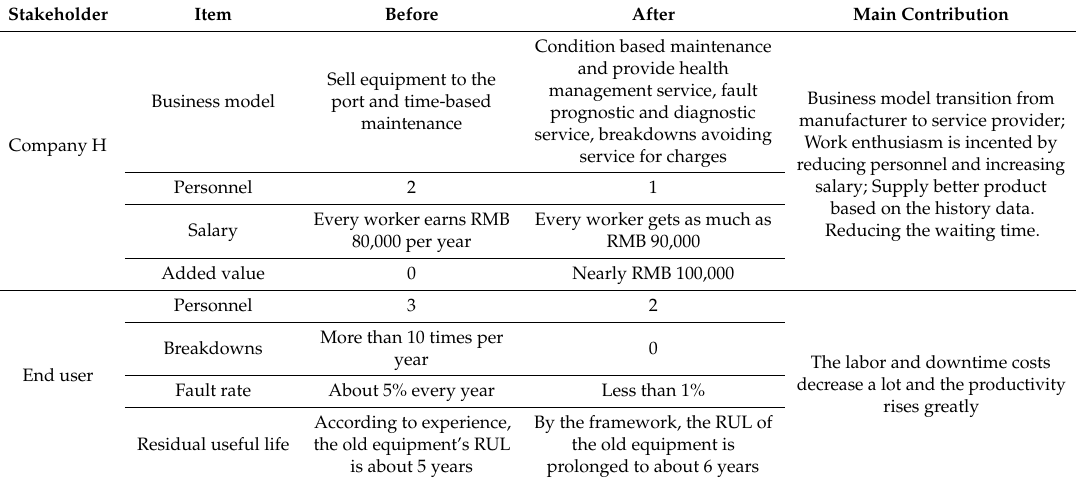
Table 5. Comparison before and after implementing the framework in